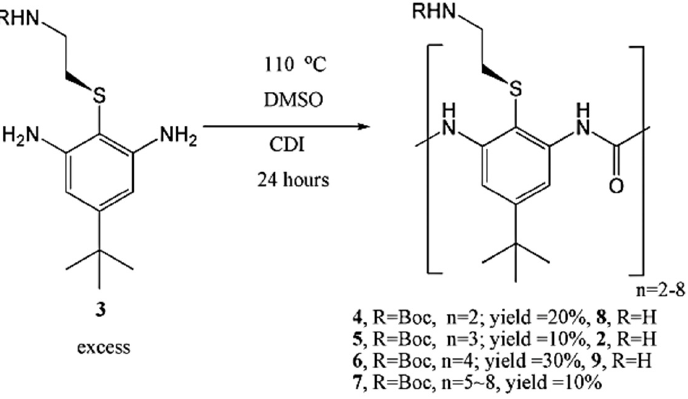
Figure 20. Synthesis of urea oligomers. From reference [54].